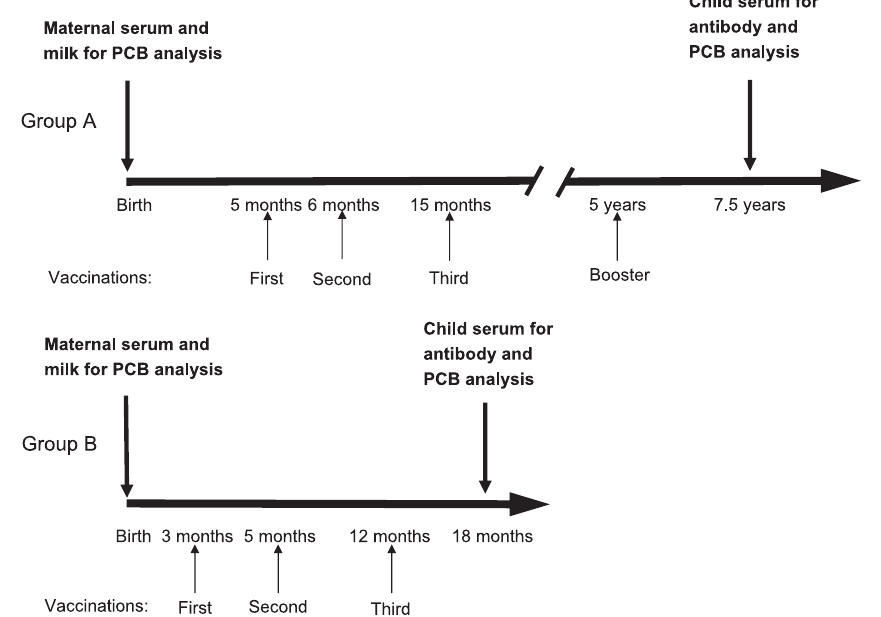
Figure 1. Events in Prospective Follow-Up of Two Birth Cohorts DOI: